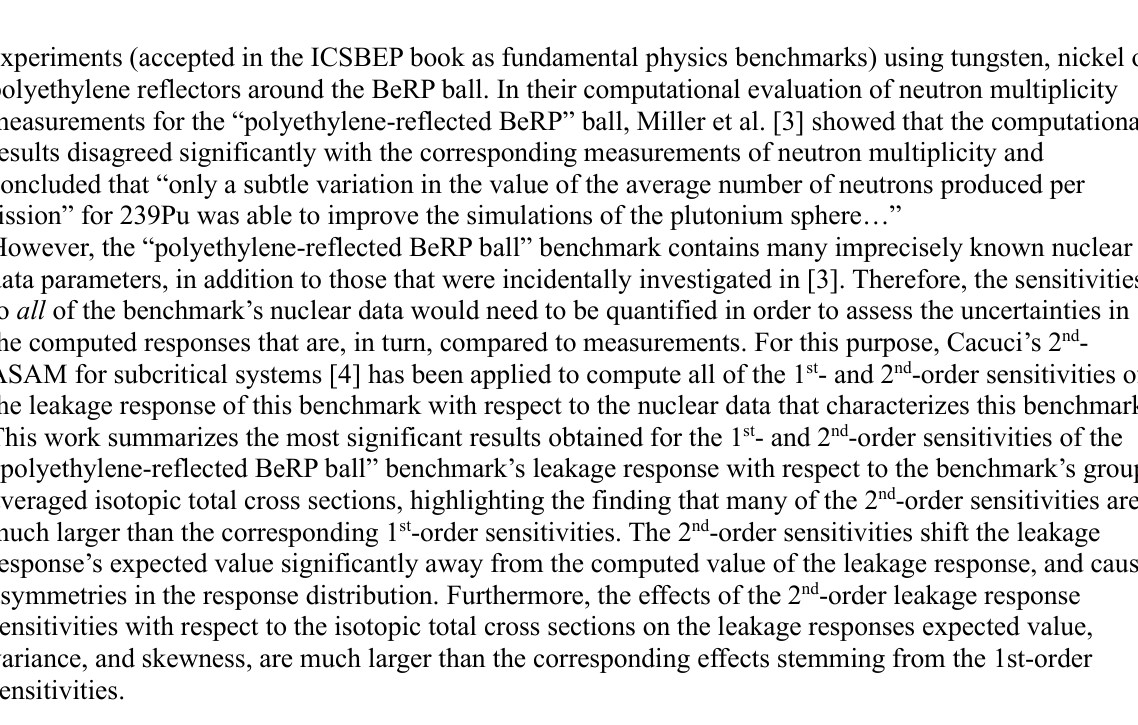
( )( ) ∂ ∂ =σ σ , of the leakage to the total , 1,...,30 g g L = , 6 , 6 t i t i